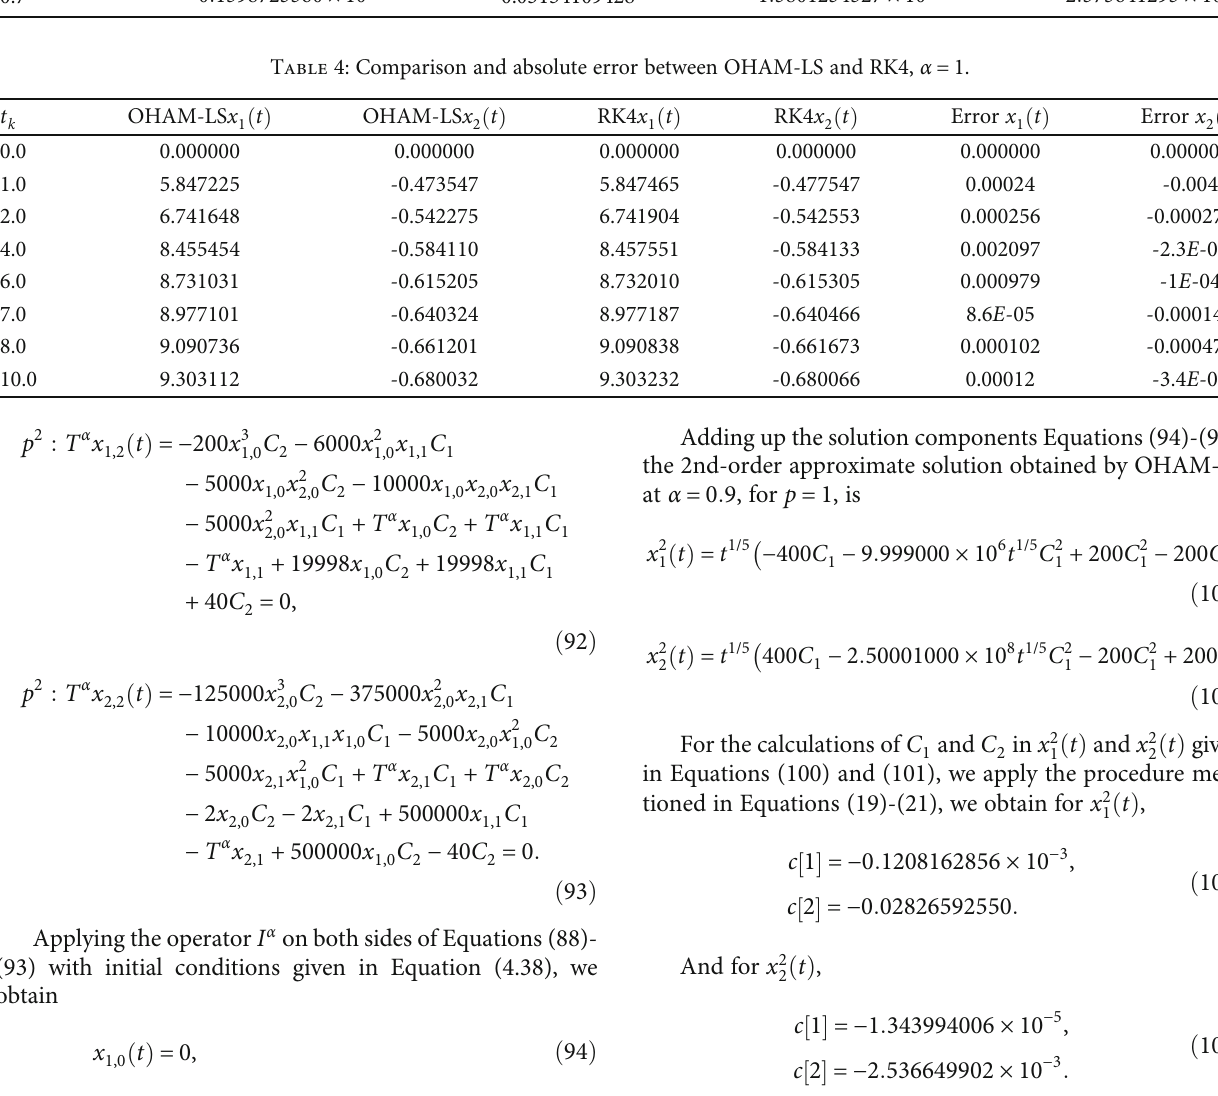
Table 3: Control-convergence parameters C